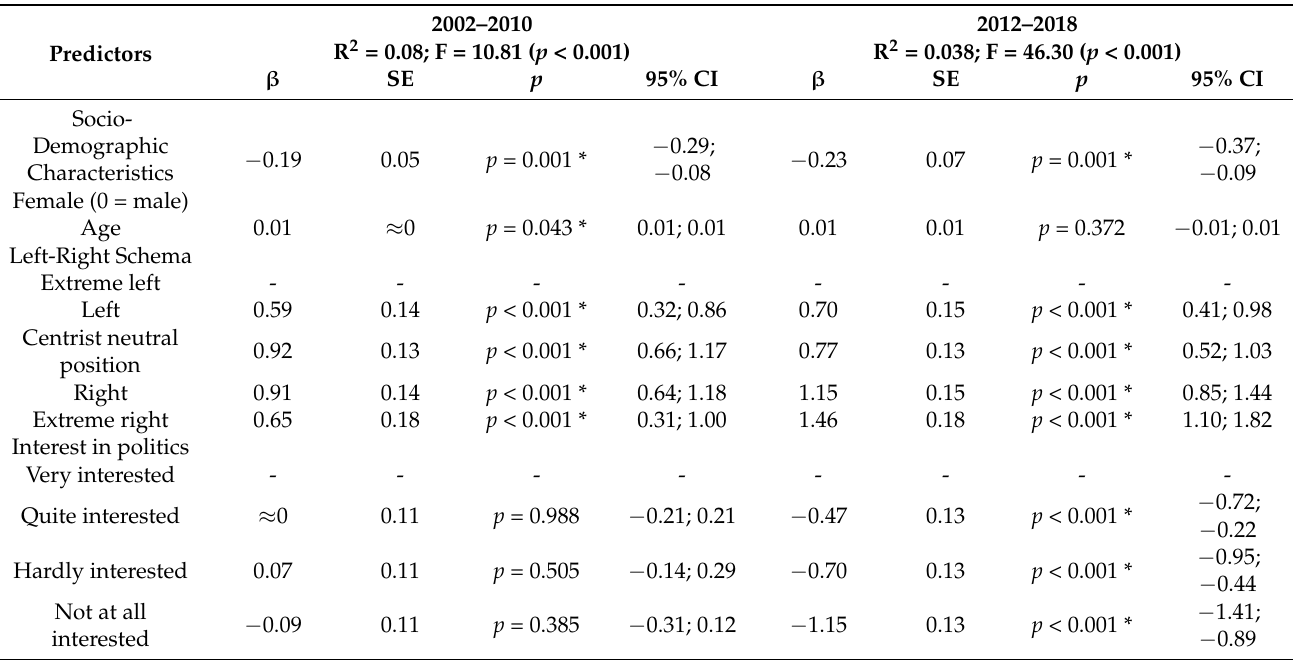
Table 5. Model 3—ideological preference.